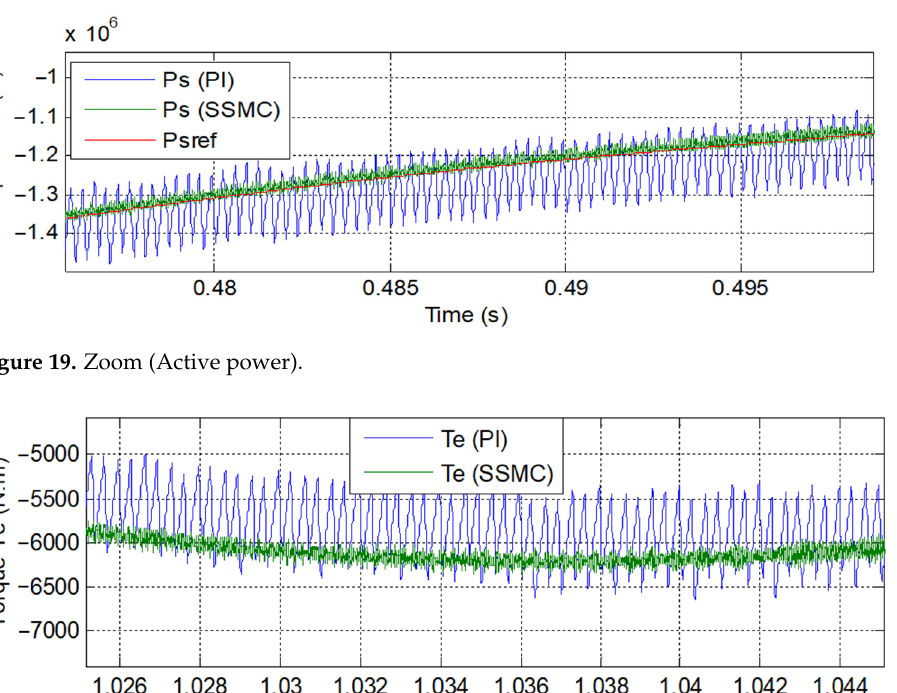
Figure 18. Current.